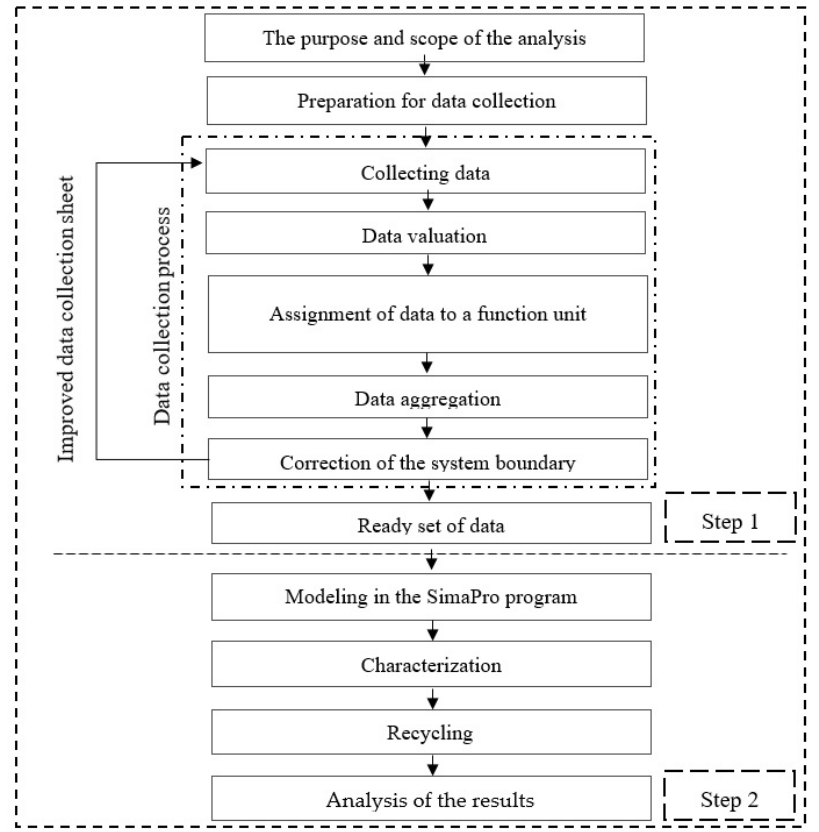
Figure 3. Detailed flow diagram of used methodology.